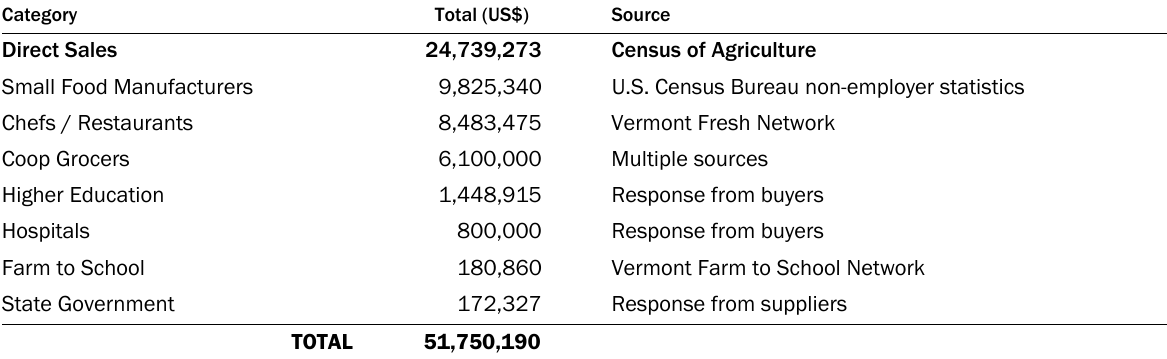
Table 3: Summary of